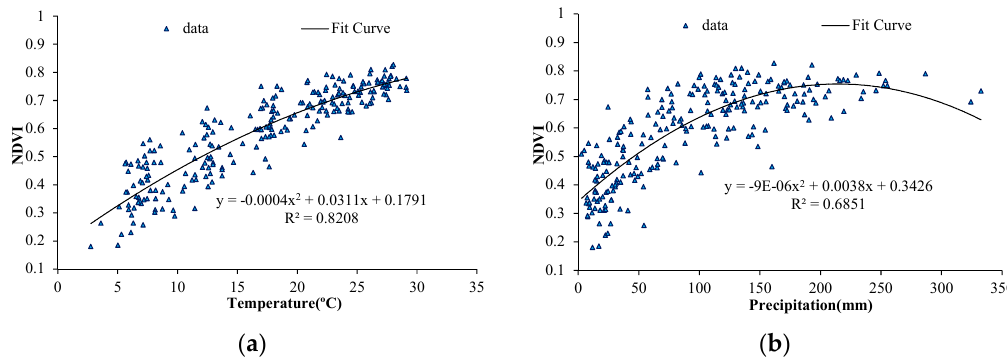
Figure 7. The scatter plot of NDVI–temperature and NDVI–precipitation in the TGR intervening basin: ( a ) nonlinear relationship between NDVI and temperature; ( b ) nonlinear relationship between NDVI and precipitation.